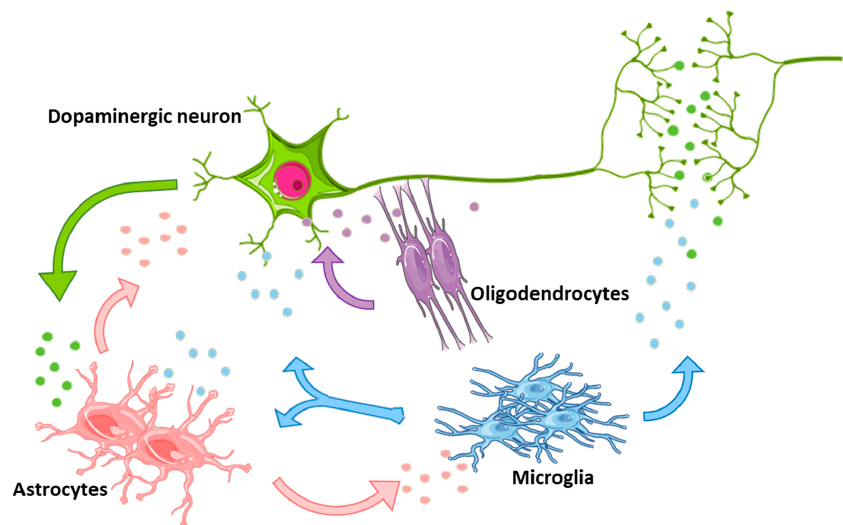
Figure 2. Schematic representation of glial cells and neurons communicating with each other by secretion of extracellular vesicles (EVs). Depending on the microenvironmental conditions these vesicles may mediate either harmful or neuroprotective effects. The colors of EVs reflect the donor cell type: green for neurons, light blue for microglia, pink for astrocytes and violet for oligodendrocytes. Table 1. Description of the detrimental effects mediated by EVs released by neurons, microglia or astrocytes on neuronal target cells.